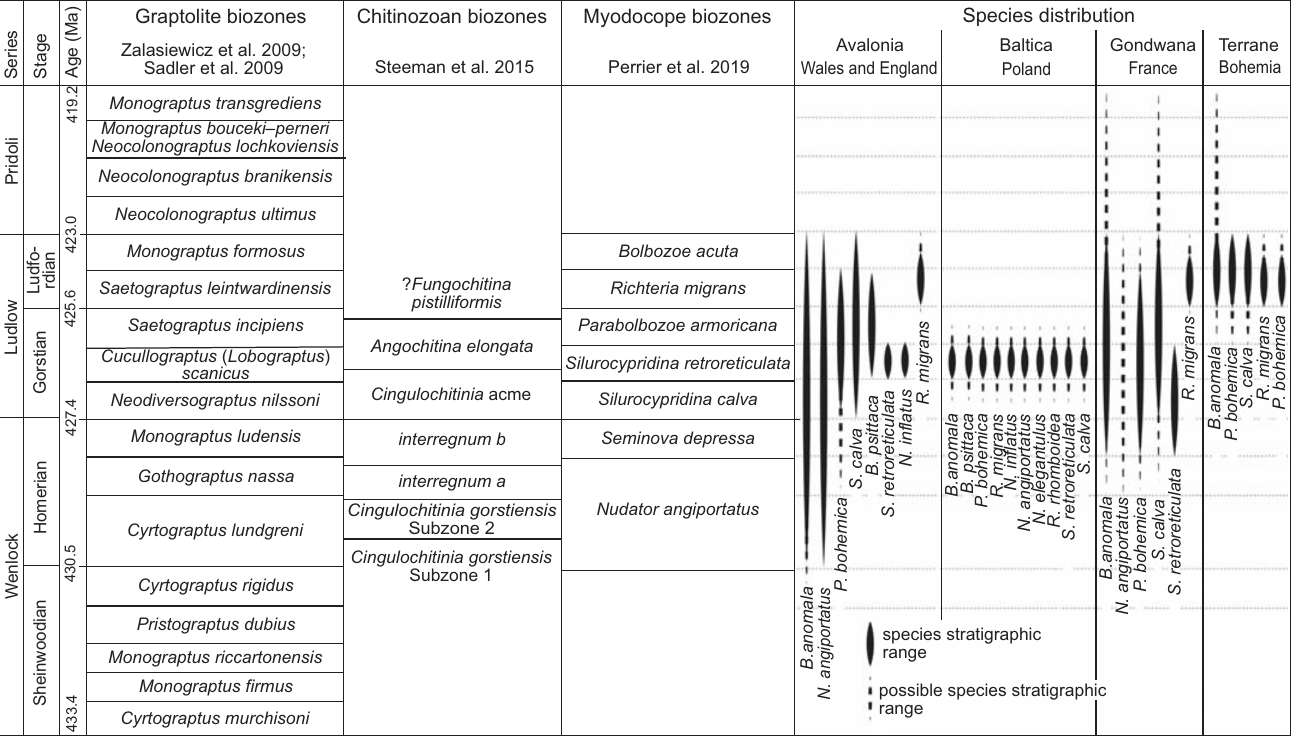
species stratigraphic range possible